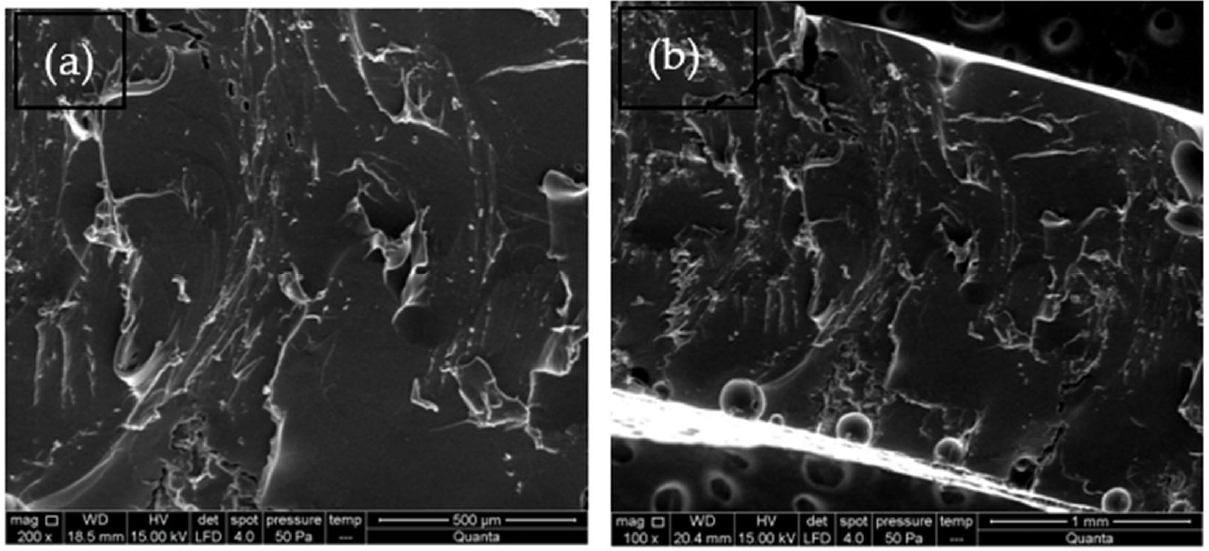
Figure 15. SEM photographs of the internal structure of the NIPUs . ( a ) Inner part, ( b ) full section .